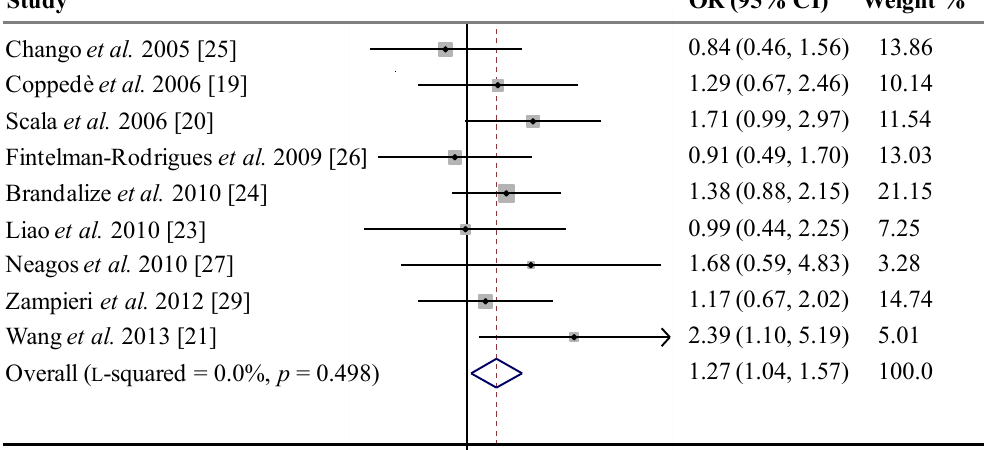
Figure 2. Fixed effects pooled odds ratio (OR) and 95% confidence intervals (CI) forest plot for the association between RFC-1 80A>G polymorphism and maternal risk for a DS birth in case-control studies, under the genetic recessive model, i.e ., GG vs . (AG or AA). The OR estimate for each study is marked with a solid grey square. The size of the square represents the weight that the corresponding study exerts in the meta-analysis. The pooled OR is represented by a diamond. The CI of the pooled estimates are displayed as the horizontal margins of the